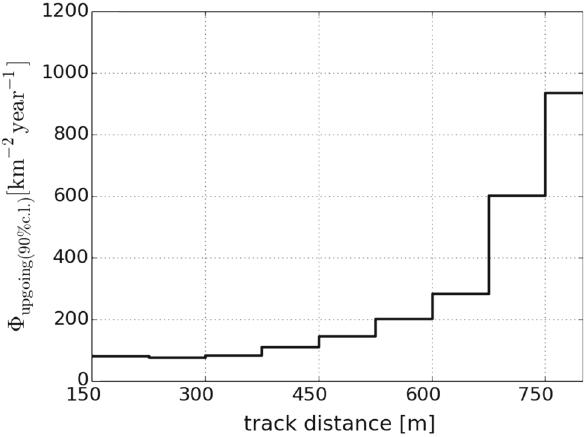
Fig. 38 Upper limit on the flux of the double tracks at IceCube assum- ing a uniform arrival direction distribution for up-going tracks